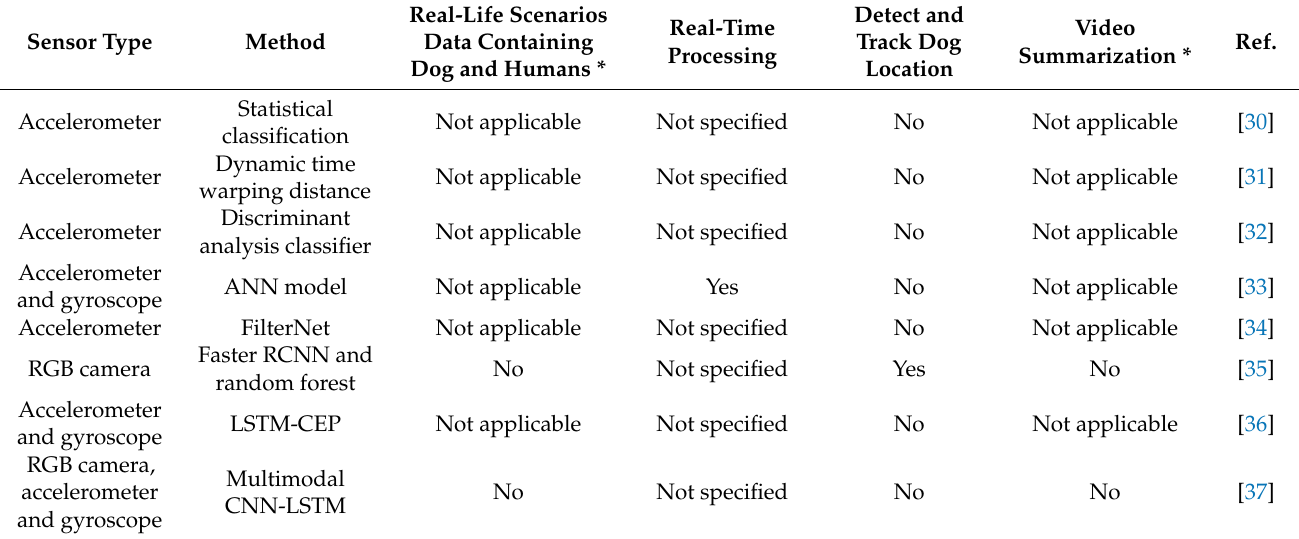
Table 1. Some recent studies on dog behavior recognition (published